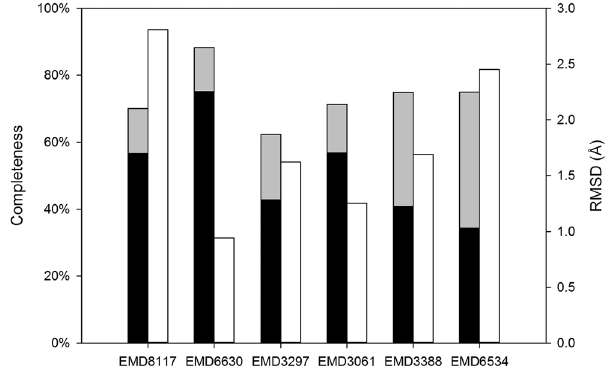
Figure 3. Completeness and RMSDs of the models built by EMBuilder from the test data sets. The shaded bars and white bars represent the completeness and RMSD, respectively. In the shaded bars, black and gray represent the percentages of C α built between 1 Å and 2 Å and within 1 Å, respectively.